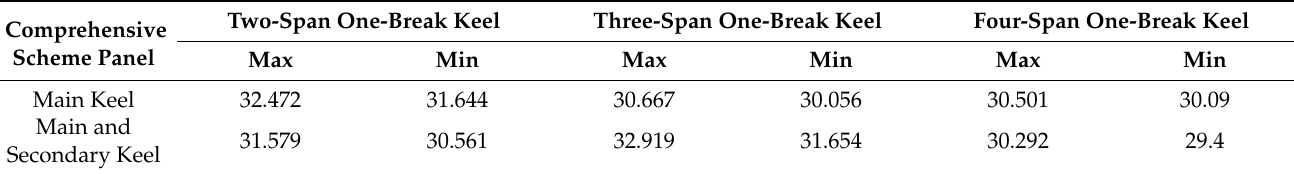
Table 13. Distance between the panel and keel of the comprehensive scheme.